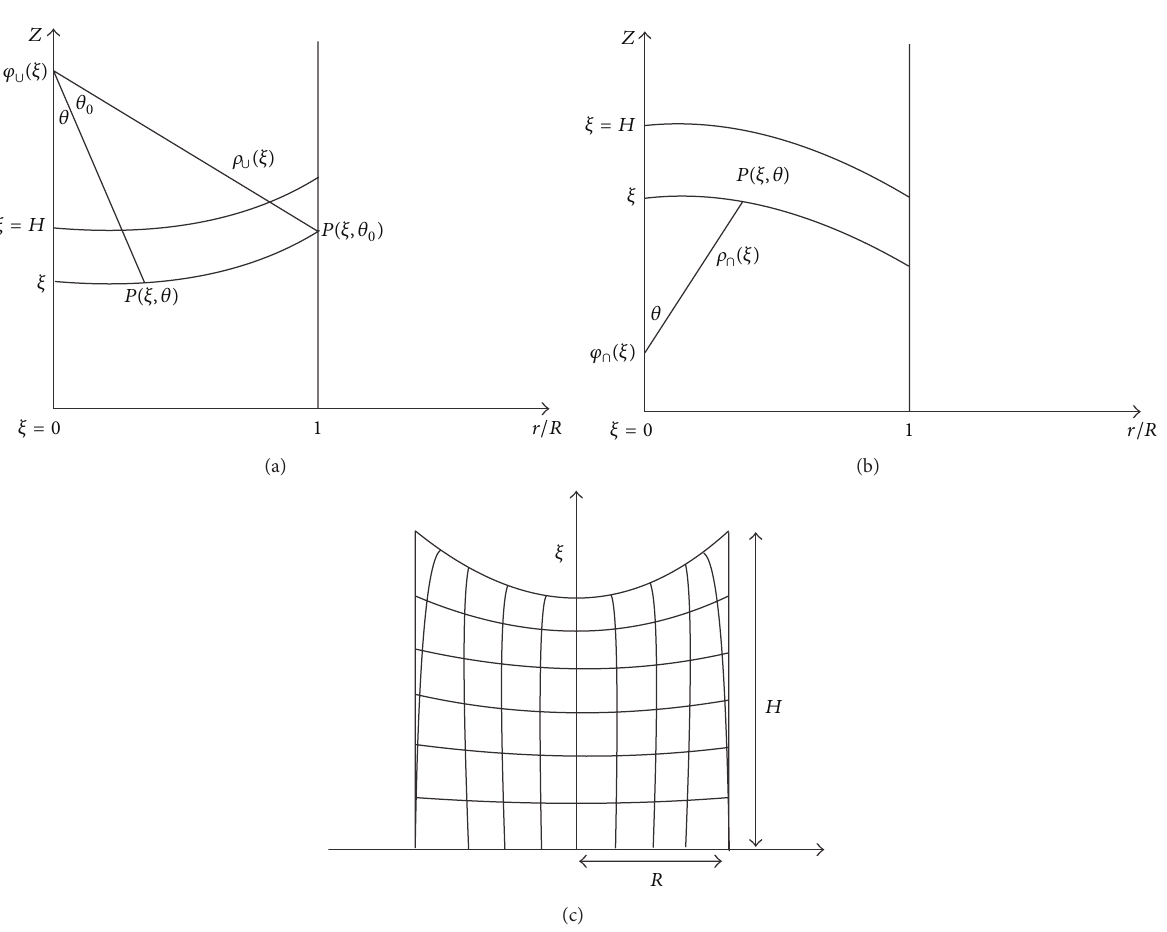
Figure 1: (a) Geometry in the case of the concave meniscus, where the radius of curvature 𝜌 ∪ (𝜉) is expressed with the local coordinate 𝜉 and the center of meniscus 𝜑 ∪ (𝜉) . (b) The geometry of the convex case. (c) The orthogonal coordinate system grid for the concave case.